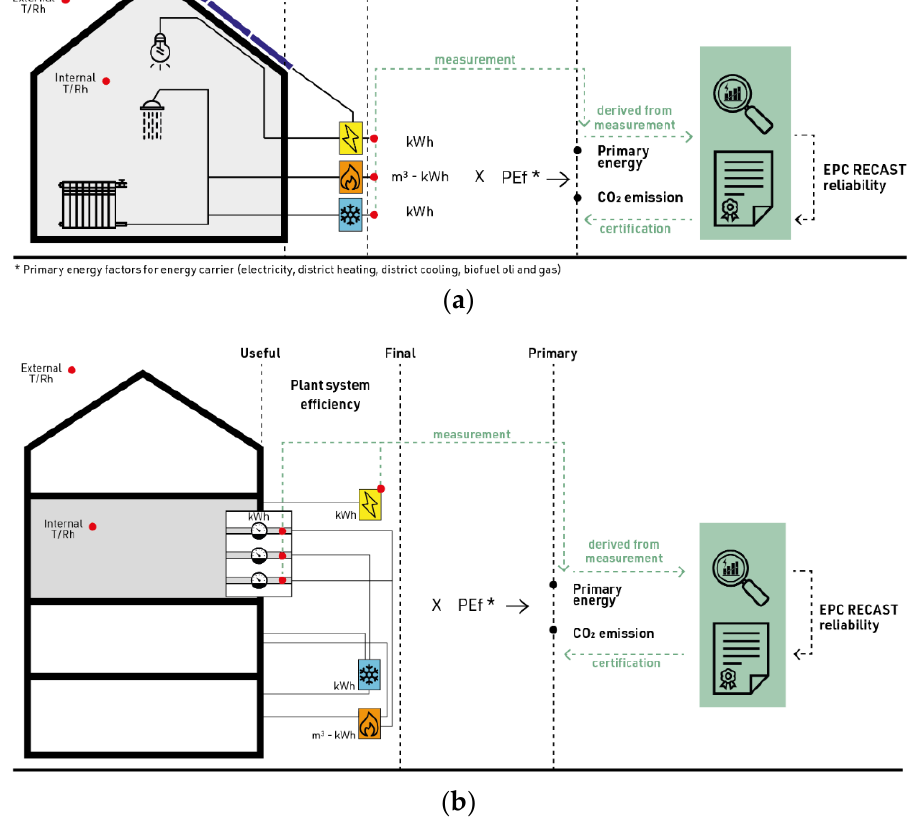
Figure 7. ( a ) Utility meter monitoring approach (Base Level and Medium Level of monitoring); ( b ) Sub-metering monitoring approach (Advanced Level of monitoring).